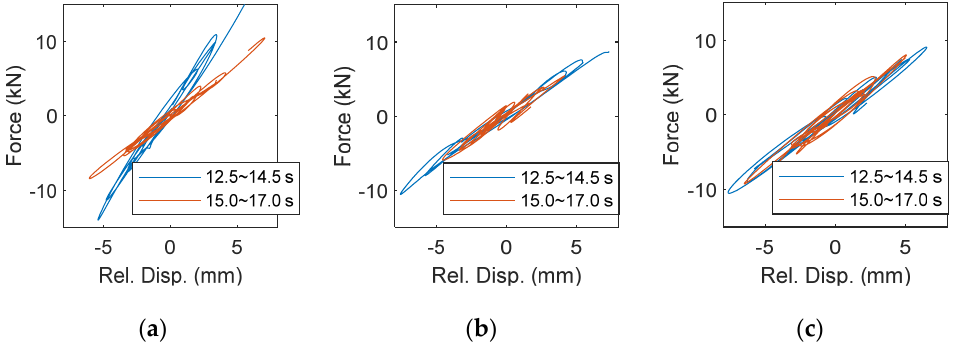
Figure 10. The hysteresis loop of each story before and after the brace is released. ( a ) First story; ( b ) second story; ( c ) third story.